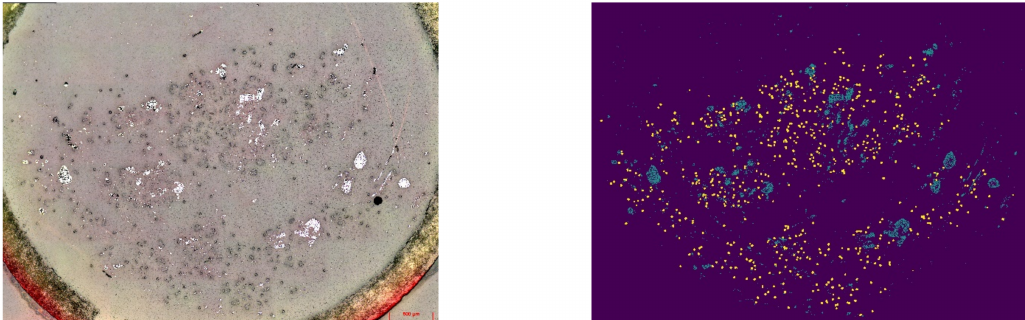
Figure 1. Micrograph of yarn with 30 t/m ( left ), identified fibers ( right ; yellow-PA6; blue-rCF).